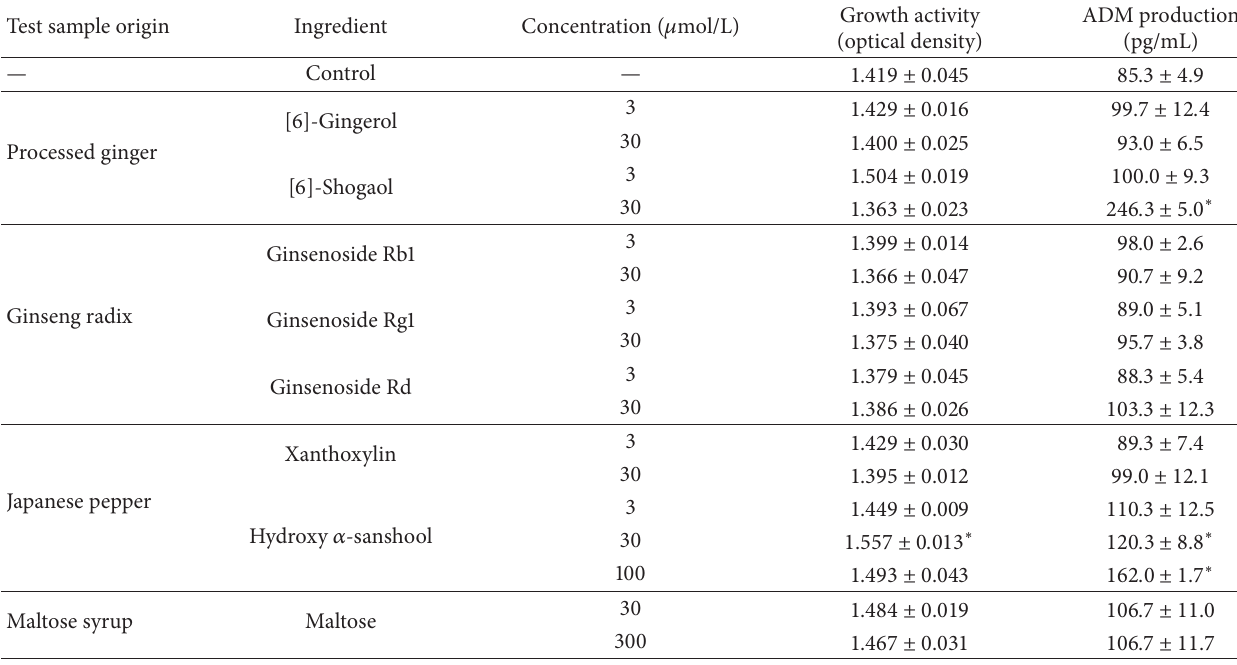
Figure 2: Adrenomedullin-enhancing activity of TU-100 in intestinal epithelial cells. Intestinal epithelial cell lines IEC-6 (a) and IEC-18 (b) settled overnight were incubated with the indicated concentrations of TU-100 for 1 day. Adrenomedullin (ADM) in the culture fluid was determined by ADM-specific EIA. 𝑁 = 4 (a), 3 (b). ∗ 𝑃 < 0.05 versus control by Dunnett test. Table 1: Screening for ingredients that enhance ADM